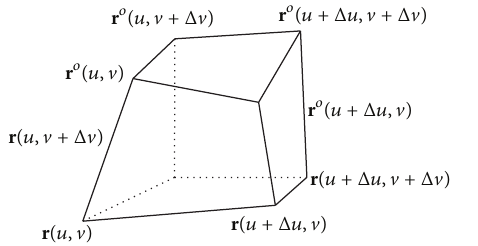
Figure 4: The volume element between r (𝑢, V ) and r 𝑜 (𝑢, V )